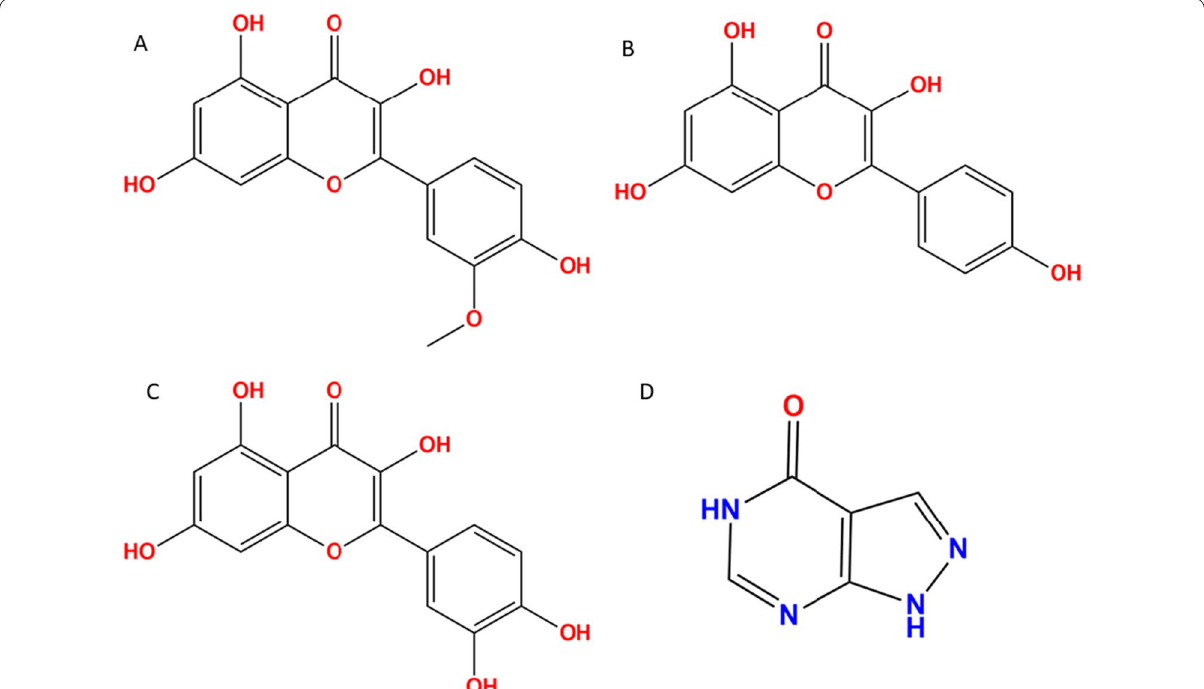
Fig. 2 2D structures of all the docked molecules: isorhamnetin ( A ); kaempferol ( B ); quercetin ( C ); and allopurinol ( D ), a standard uricostatic